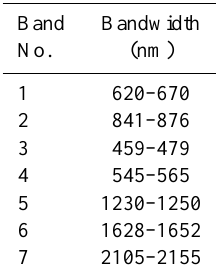
Table 1. Spectral definition of the seven MODIS channels at 500m